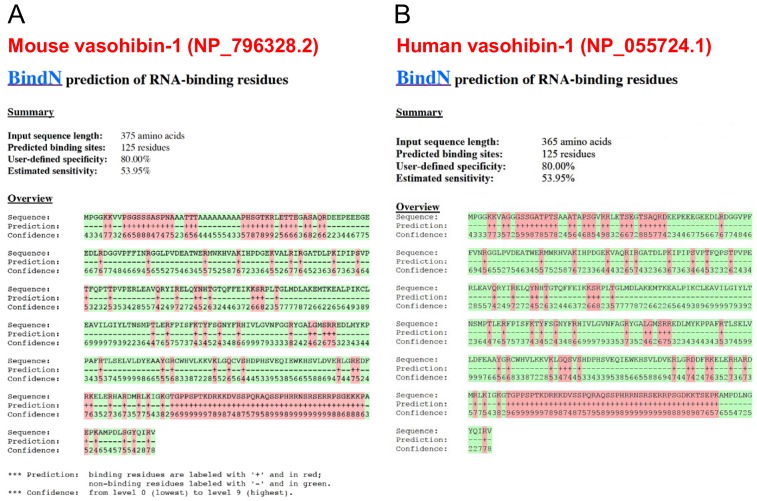
Conservation of predicted RNA-binding domains in mouse and human vasohibin-1.(A, B) RNA-binding domains in mouse (A) and human (B) VASH1 proteins were predicted using BindN software (https://omictools.com/bindn-2-tool).